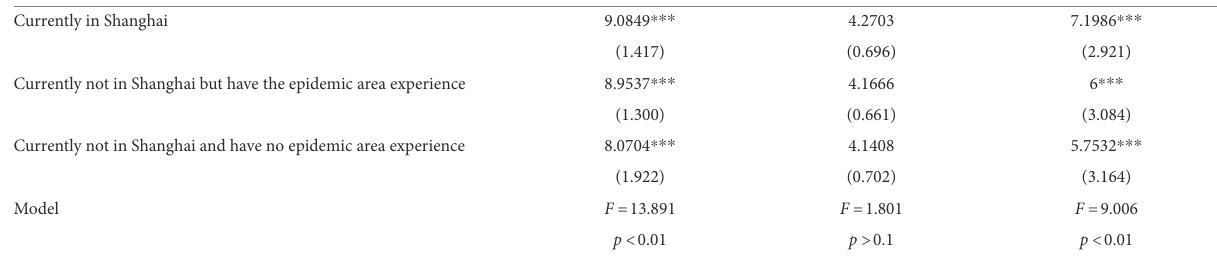
TABLE 3 Spatiotemporal involvement on FBM properties. Spatiotemporal involvement